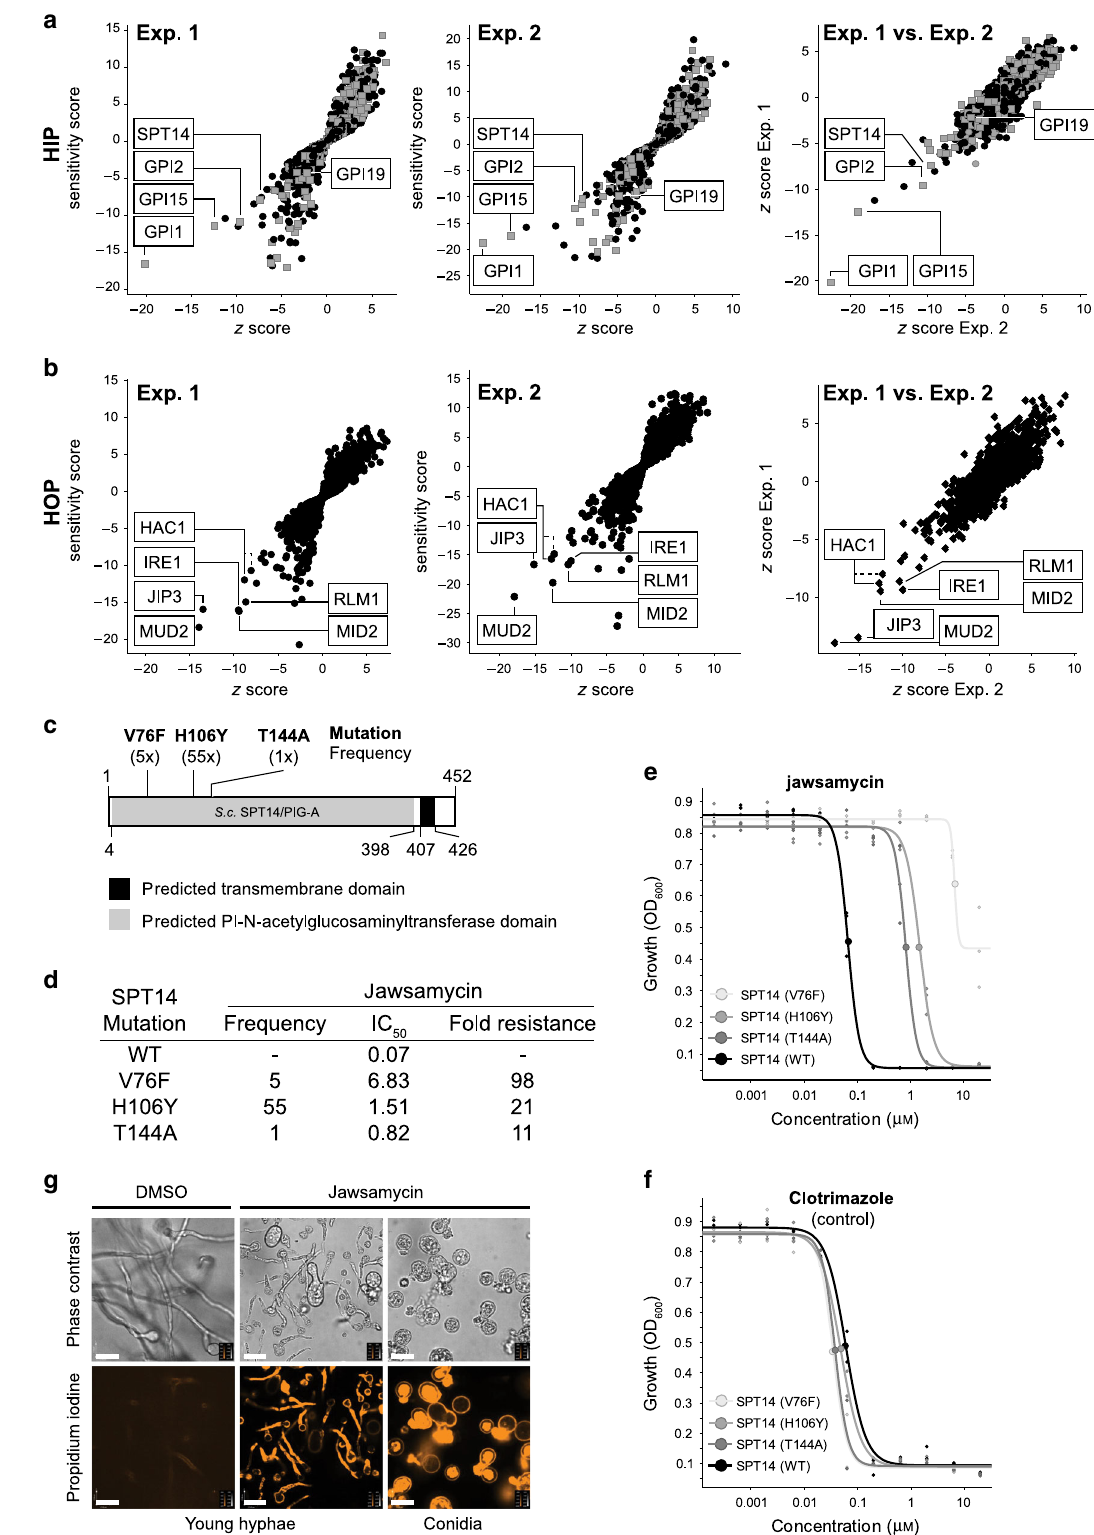
IRE1 scored as prominent hits in the HOP experiment (Fig. 2b). As for the hits from the HIP experiment, hypersensitivity of hac1 and ire1 deletion strains was con fi rmed in single strain experiments (Supplementary Fig. 2b). Therefore, unbiased chemogenomic pro fi ling experiments identi fi ed heterozygous